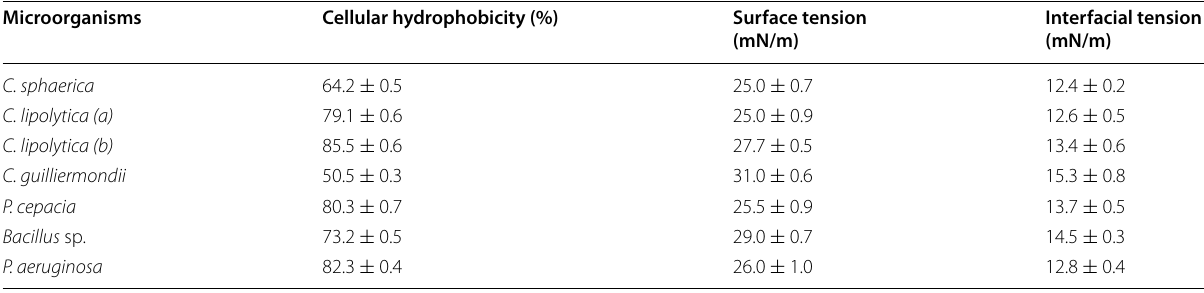
Results are expressed as mean